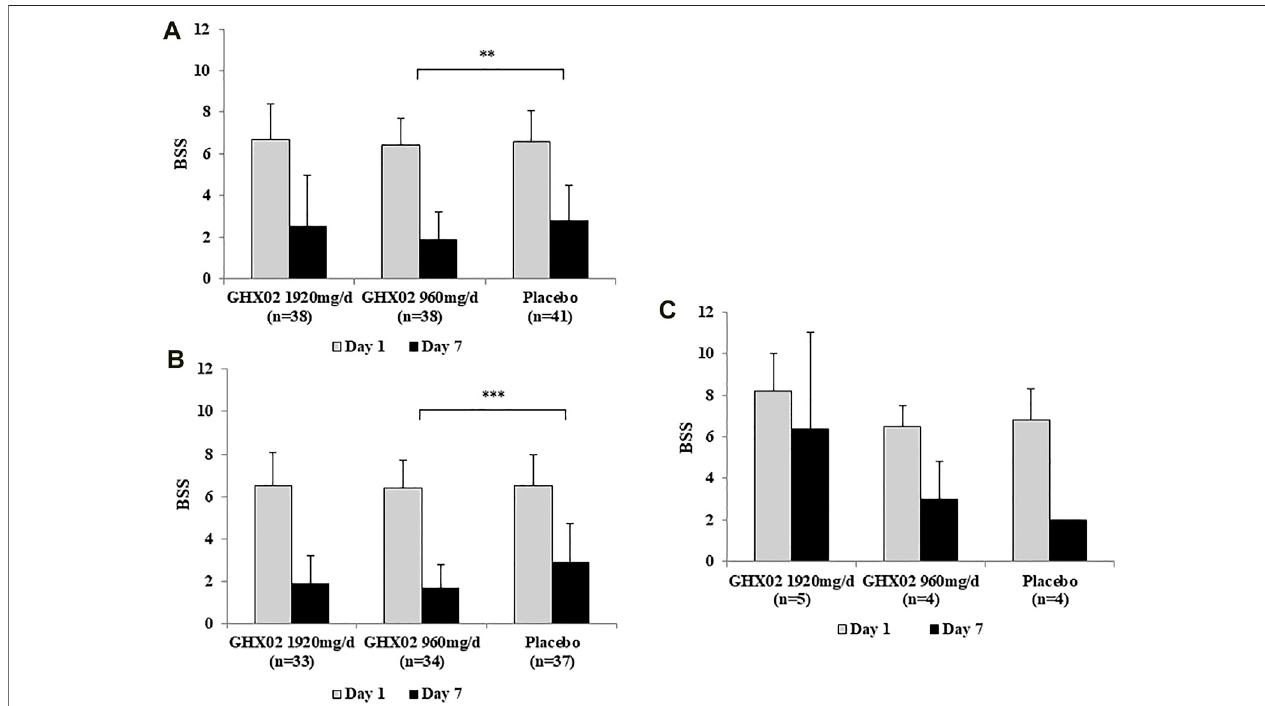
FIGURE 2 | Figure 2 . Bronchitis Severity Score (BSS) from Day 1 to Day 7. (A) Total population (B) AB subgroup (C) AECB subgroup. Results are expressed as mean ± SDwith95%con fi denceintervals(CIs)inFASanalysis. p -valuesindicatesigni fi canceofmeandifferencesinthevaluebetweengroups(* p < 0.05,** p < 0.01,and